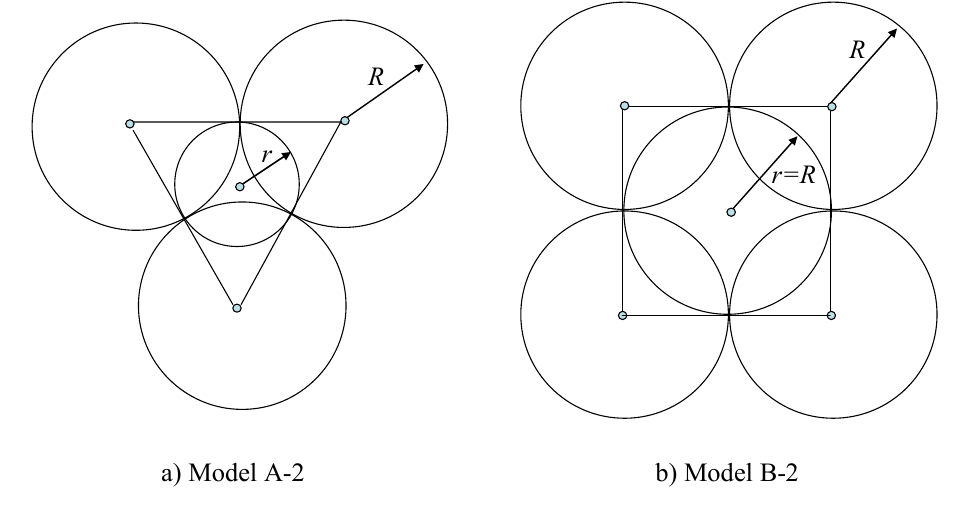
Figure 2. Coverage with two sensing